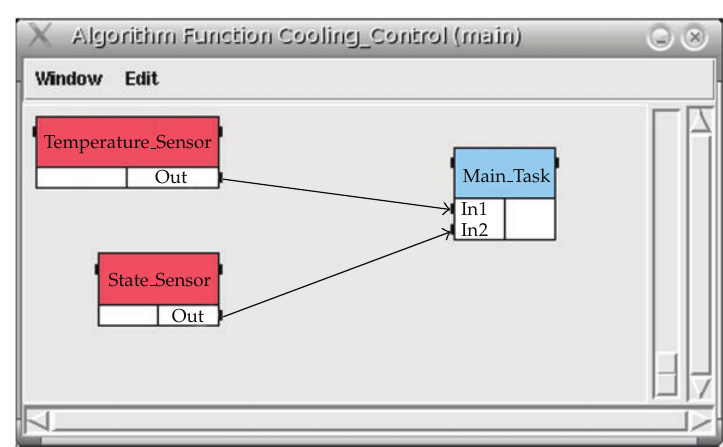
Figure 7: Cooling control (cid:3) tasks graph (cid:4) .